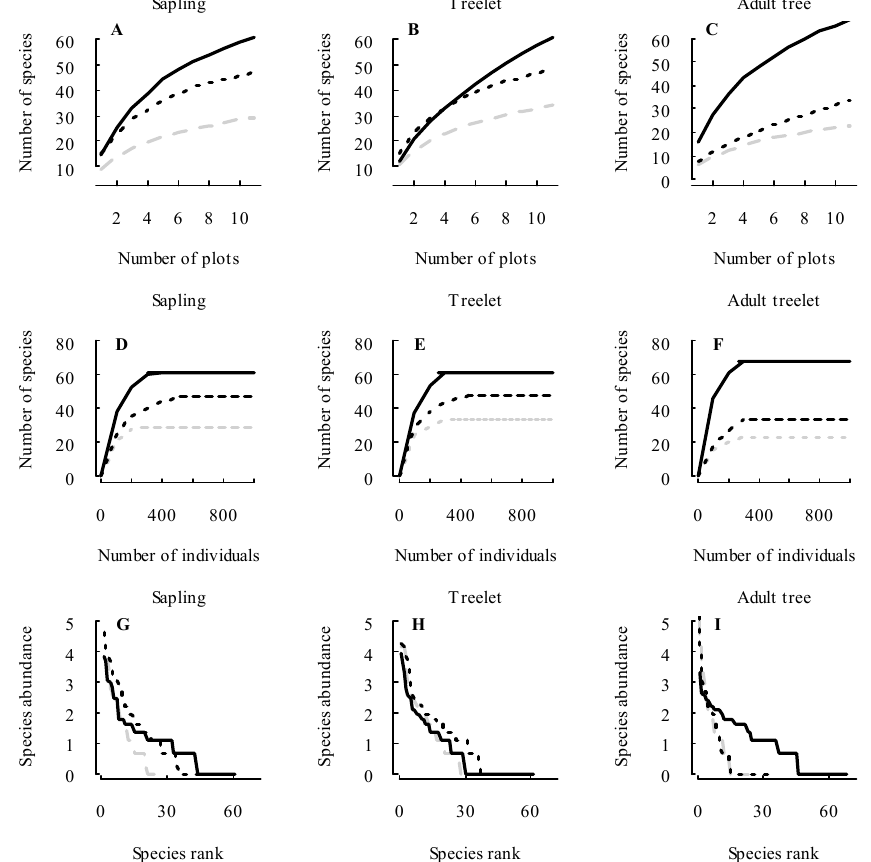
Figure 2. The species–area accumulation curves ( A – C ), species–individual accumulation curves ( D – F ), and species rank–abundance diagrams ( G – I ) for saplings, treelets, and adult trees among the different recovery ages (40-year forests, 60-year forests, and old-growth forests) in the tropical monsoon forests. Saplings, 1 cm ≤ DBH < 5 cm; treelets, 5 cm ≤ DBH < 10 cm, and adult trees DBH ≥ 10 cm. DBH, diameter at breast height. Grey dashed lines represented 40-year forests, black dotted lines represented 60-year forests, and black solid lines represented old-growth